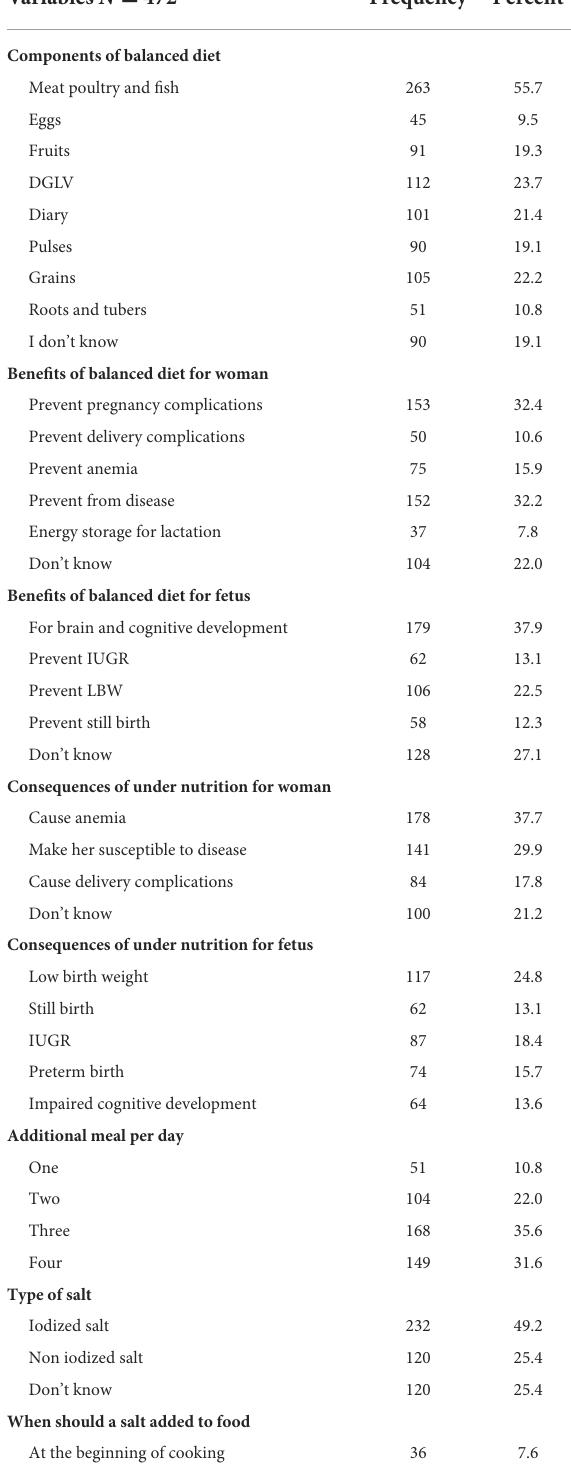
TABLE 3 Knowledge of pregnant mothers attending ANC service on optimal nutrition during pregnancy in East Shoa zone, Ethiopia, from June to August